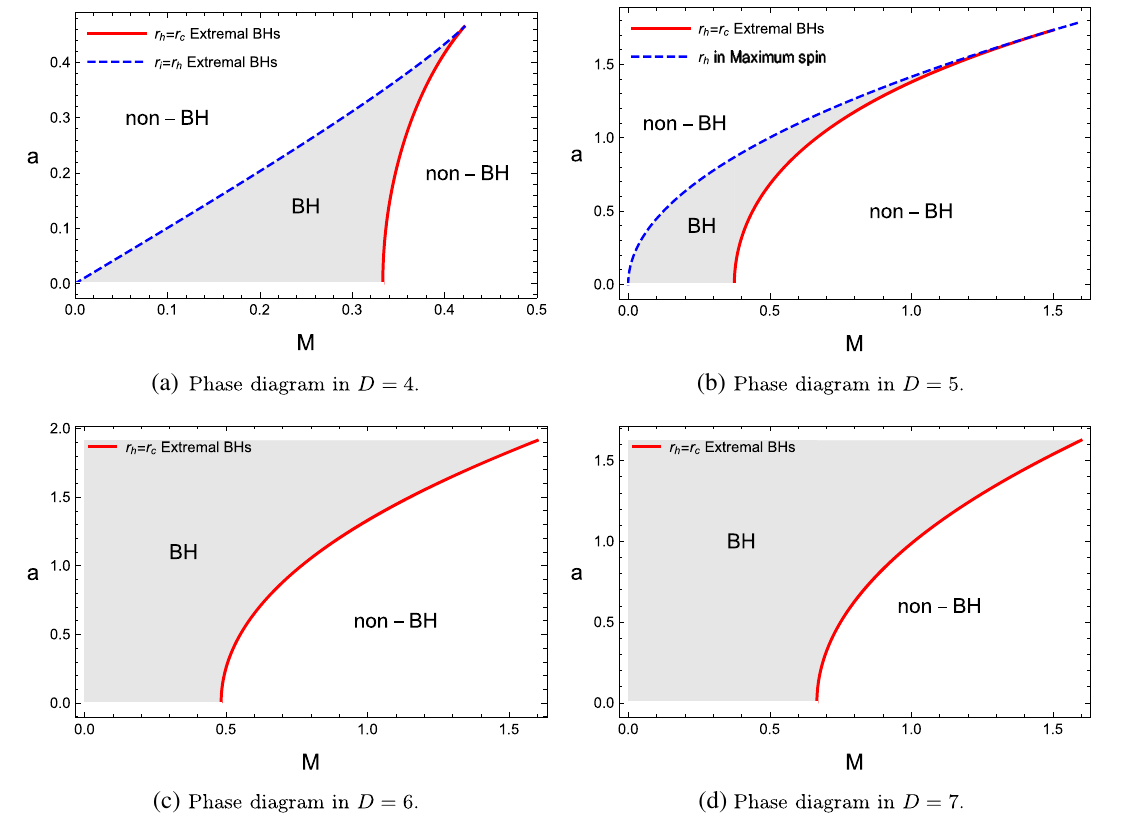
Fig. 1 Phase diagrams about mass and spin parameters for the positive cosmological constants, (cid:8) = 1